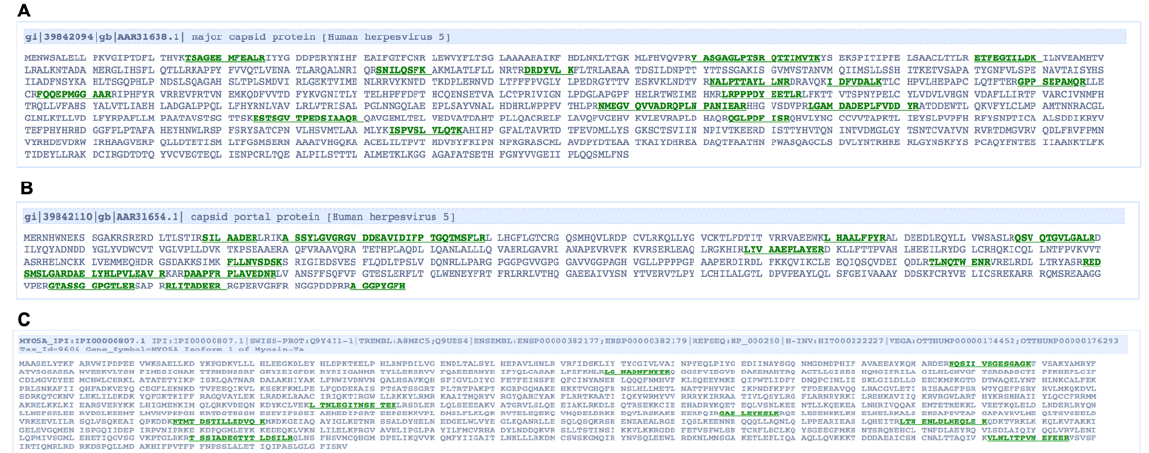
Figure 1. HFFs were infected with 53-F (MOI 3), nuclear lysates were harvested at 72 hpi, and subjected to α -FLAG IP. Proteins were resolved on an SDS-polyacrylamide gel and extracted bands were sent for LC-MS/MS analysis. Sequences of major capsid protein ( A ), capsid portal protein ( B ), and myosin Va ( C ) are shown with positions of unique peptides detected in the LC-MS/MS analysis highlighted in green.